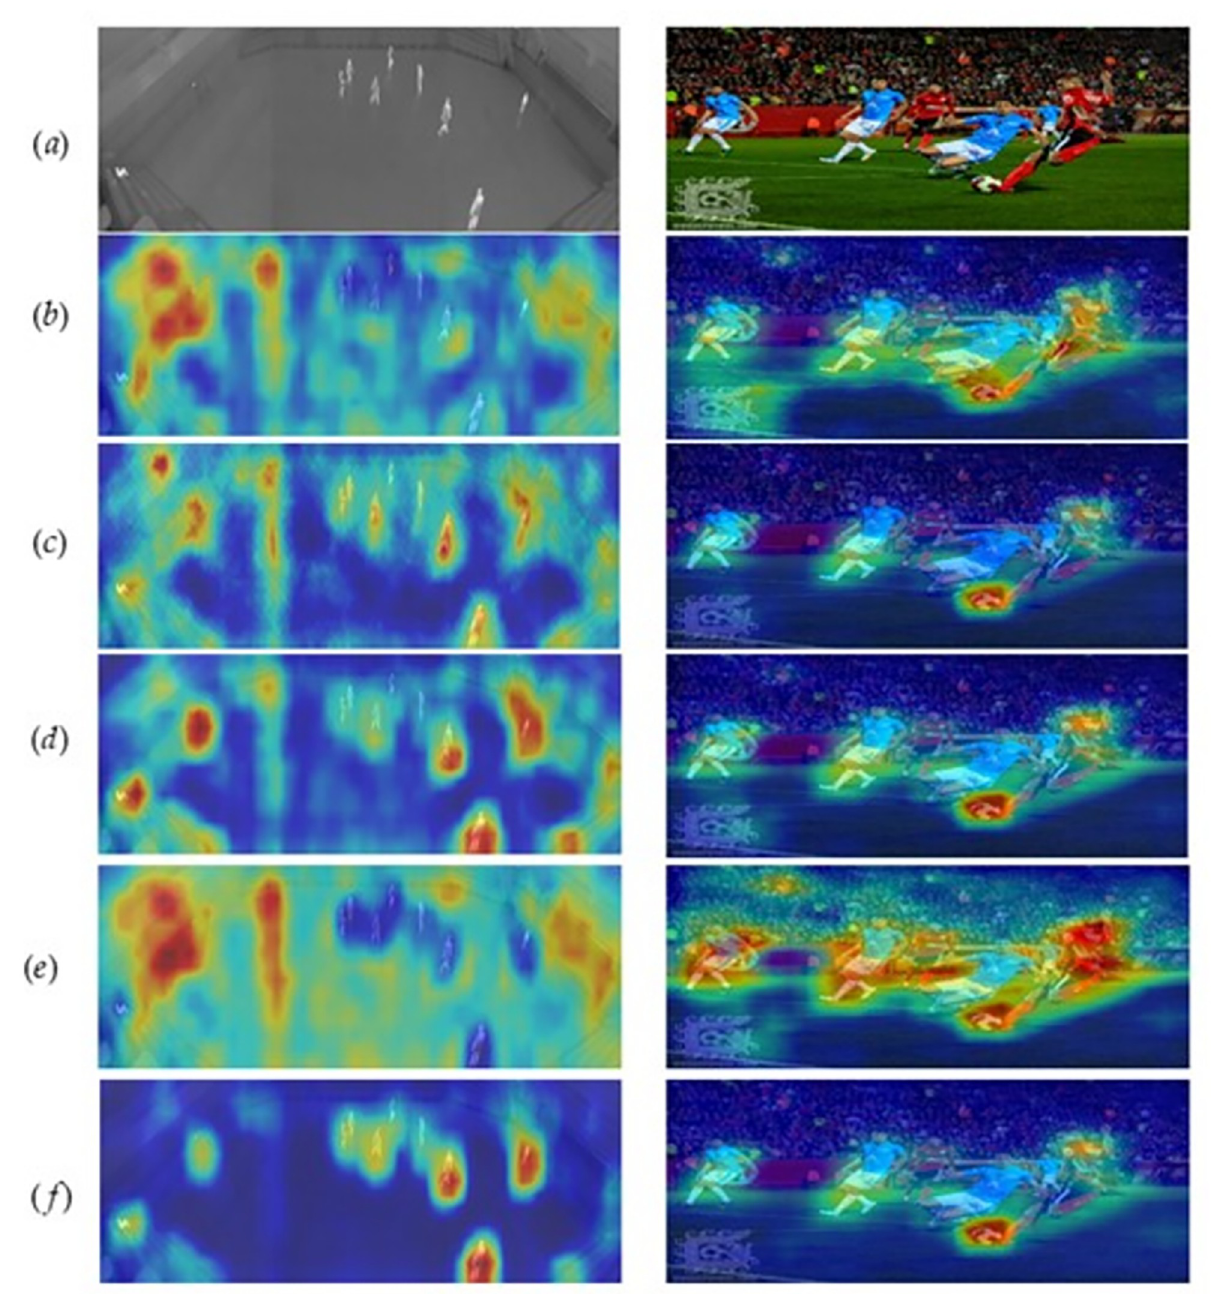
Fig 2. Visualization of different components. (a) represents the original image; (b) represents MFCN 2,3 + BCFPN . (c) and (d) represent the visual demonstrations of MFCN 1,2 + BCFPN and MFCN 1,3 + BCFPN , respectively. (e) represents the BDFPN component. (f) represents the visual presentation of LUANets we mentioned, which includes three levels of detailed information MGUN+BCFPN: low-level, medium-level, and high-level.